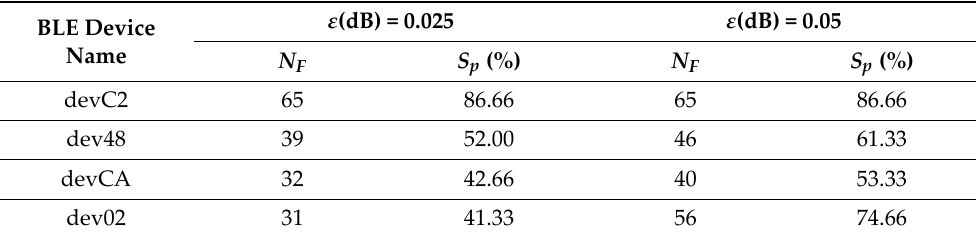
Table 4. Results of the comparison of the average PSDs of anechoic chamber experiments with the ones of open‑space experiments for each